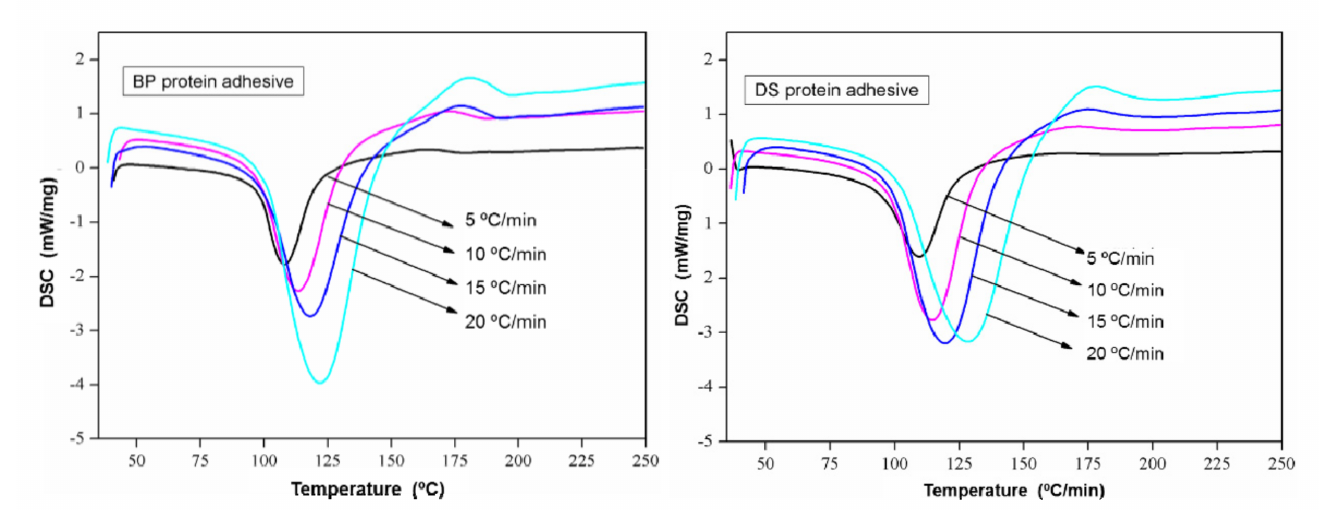
Figure 2. DSC curves at different heating rates of BP and DS protein adhesives.